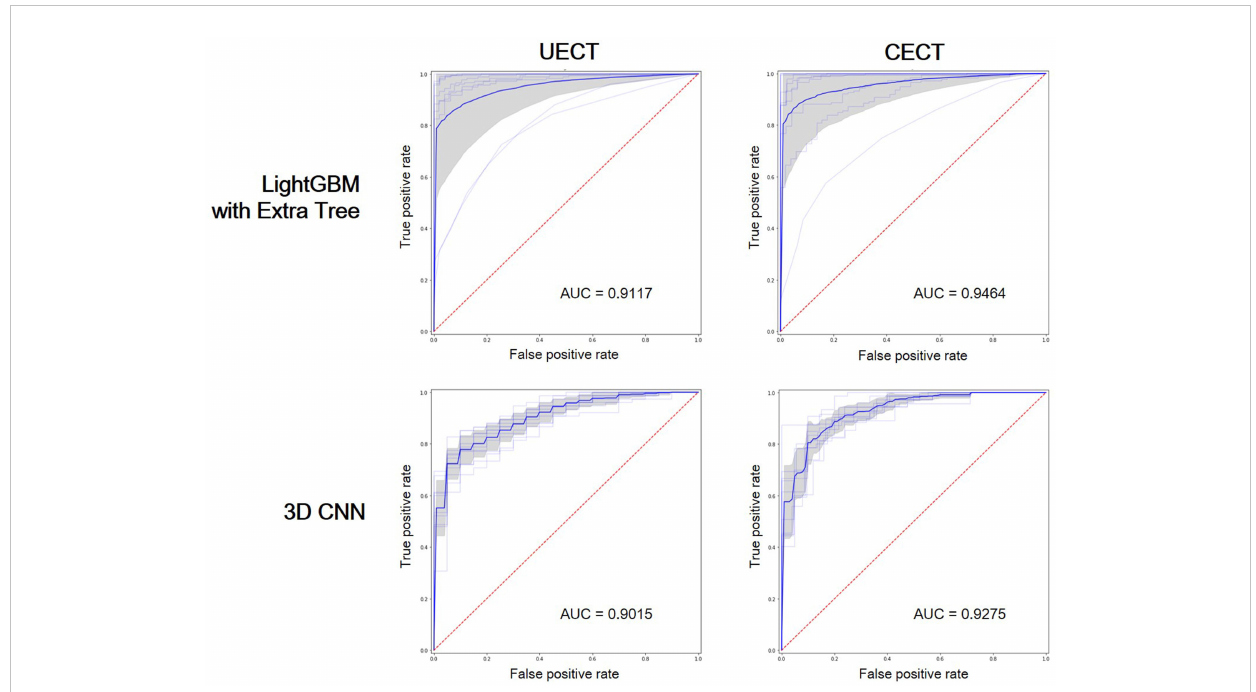
FIGURE 3 Receiver operating characteristic (ROC) curves showed the performance of LightGBM with Extra Tree and 3D CNN on UECT and CECT. AUC, area under